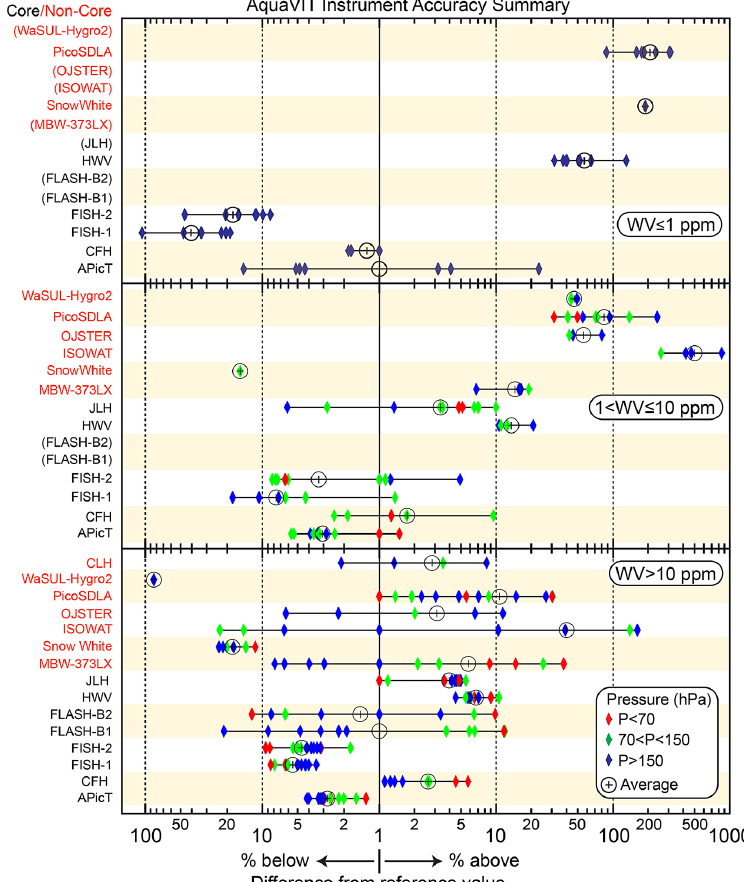
Figure 6. Summary plot of the core and non-core instrument intercomparison results for the five-day static experiment series. The instruments are identified on the left of each panel. Each panel is labeled by the range of reference water vapor mixing ratios. The chamber pressure range is indicated by the symbol color. The symbols represent the average difference within a segment from the reference water vapor value for that segment. Data from the FLASH instruments are not included in the reference value (see text). The segments varied from 900 to 3600s in length, with most being 1800s (Table 3). The differences are plotted on two separate log scales for values more than 1% above or below the reference value. Differences equal to or less than 1% are plotted at a value of 1%. The average of all segments for an instrument is shown with the circle/plus symbol. Data are not available for all segments for each instrument, and some instruments have no data for the lower mixing ratio ranges. Instrument names in parentheses in a panel have no results in the associated mixing ratio